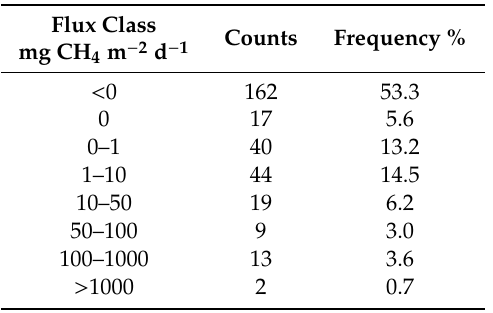
Table 1. Frequency distribution of CH 4 fluxes measured from each single chamber in the downhill area from May to November 2010 ( n = 304).